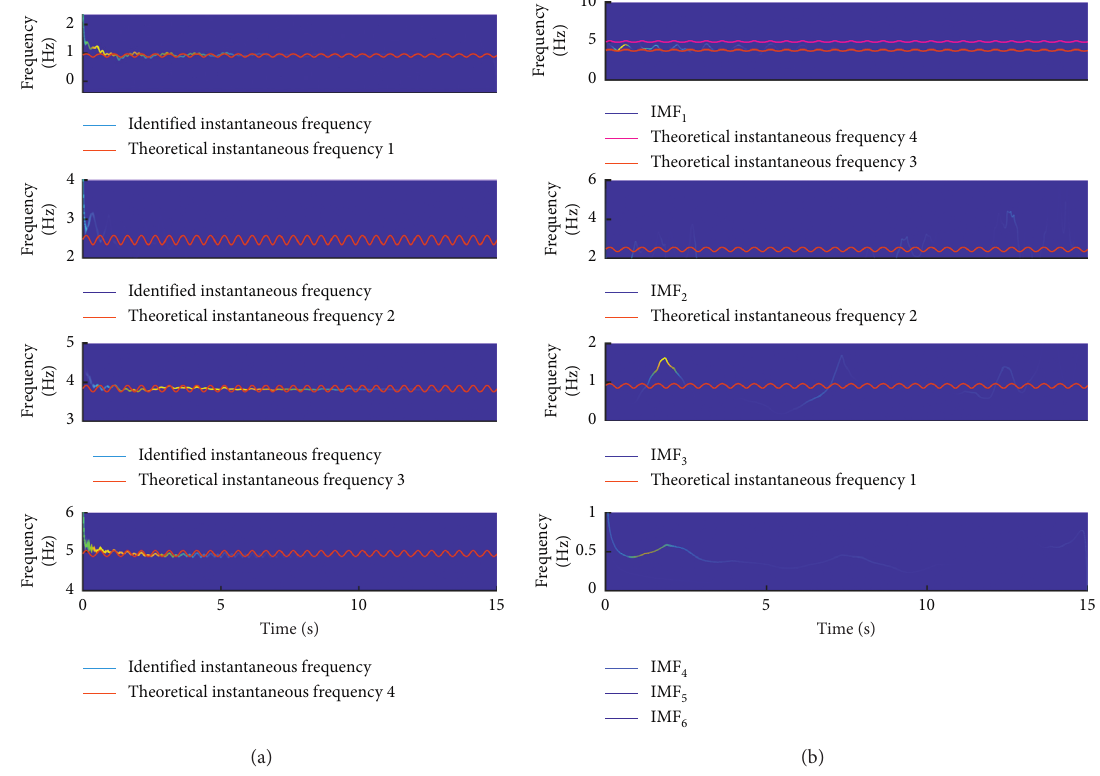
Figure 9: Identification of time-frequency spectrum and theoretical frequency by the numerical model in VMD and EMD methods. (a) VMD identification of time-frequency spectrum. (b) EMD identification of time-frequency spectrum.